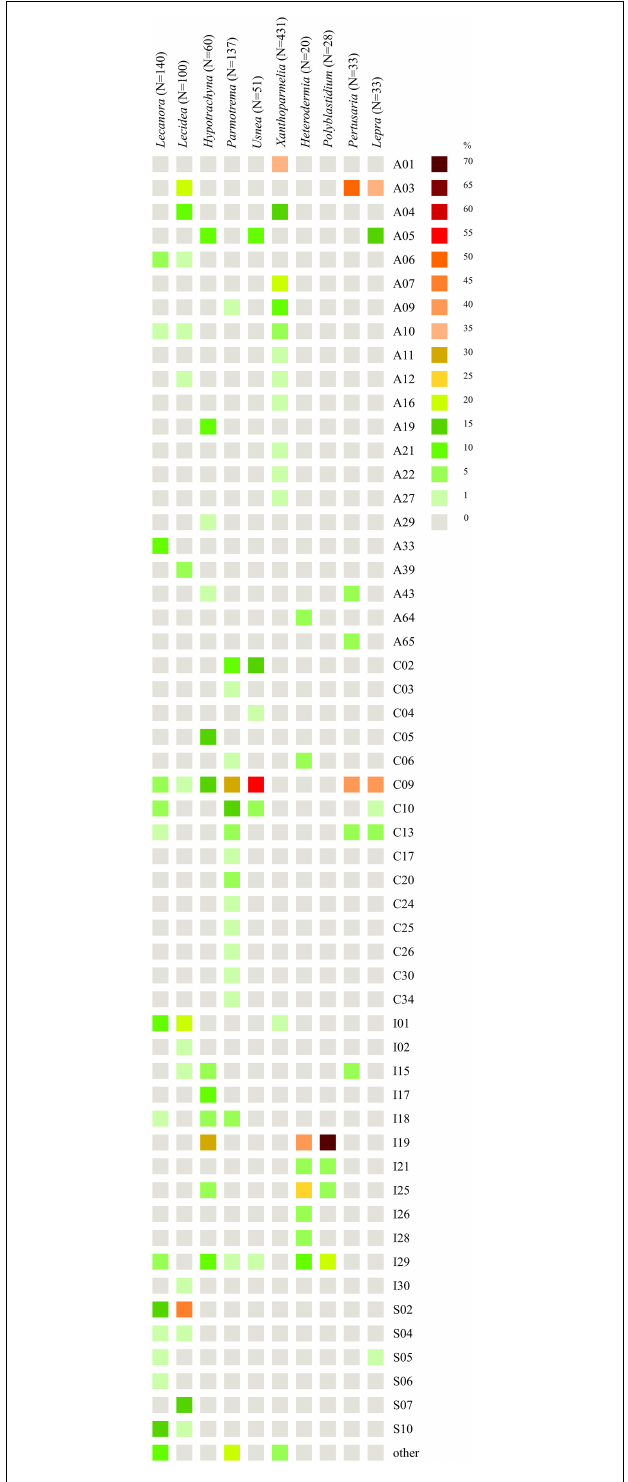
FIGURE 10 | Heatmap of relative abundance of Trebouxia OTUs in genera Lecanora (Lecanoraceae), Lecidea (Lecideaceae), Hypotrachyna , Parmotrema , Usnea , Xanthoparmelia (Parmeliaceae), Heterodermia , Polyblastidium (Physciaceae), Pertusaria (Pertusariaceae), and Lepra